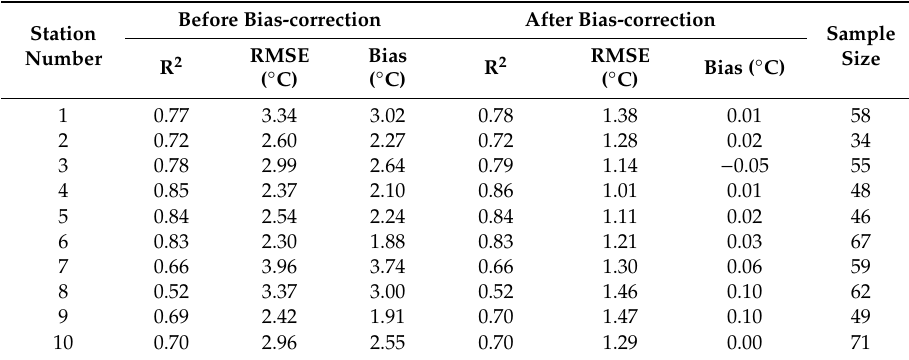
Table A2. The relationship between clear sky MODIS LSTs and the before-and-after 1 km bias-corrected in situ LSTs during July and August from 2013 to 2018 for the 10 stations at nighttime. Refer to Figure 1 for station numbers.